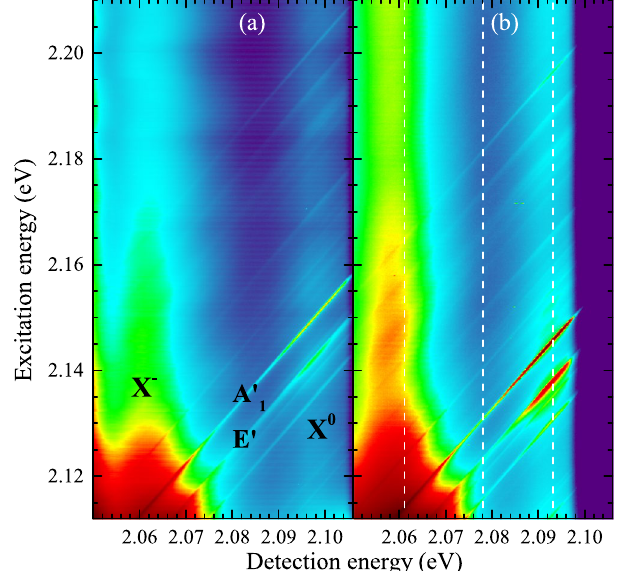
Figure 2. Optical response of monolayer WS 2 at T = 5 K plotted as a function of excitation energy. The excitation power was equal to ( a ) 10 μ W and ( b ) 50 μ W. The white dashed vertical lines denote the “cross- sections” of the map taken at (from the lowest energy) E = 2.061 eV (X − emission), E = 2.072 eV, and E = 2.093 eV (X 0 emission) and presented in Fig. 3.